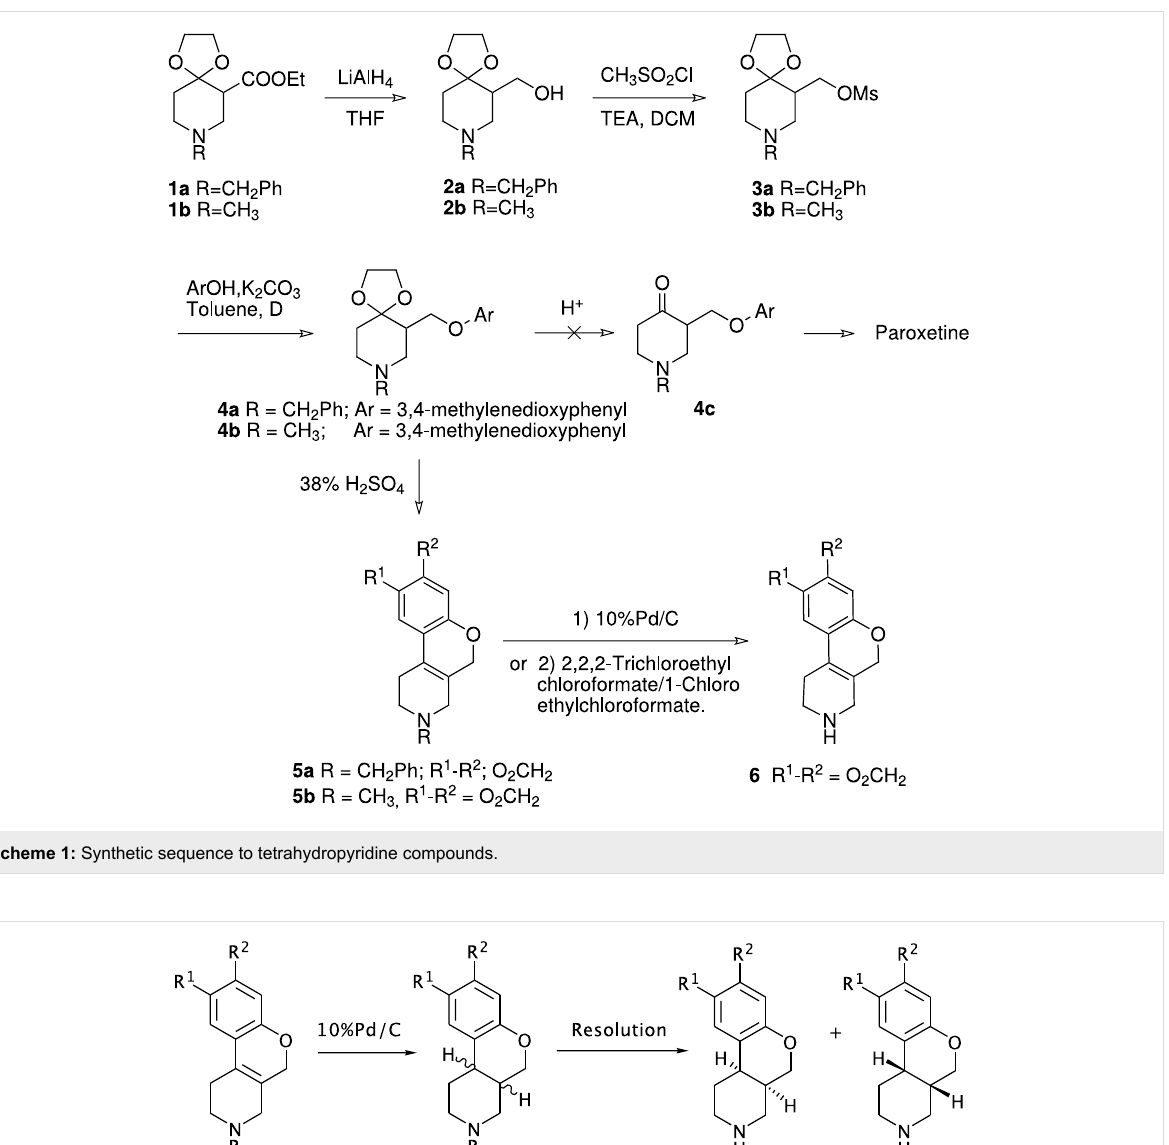
Scheme 2: Resolution of enantiomers using D(-) mandelic